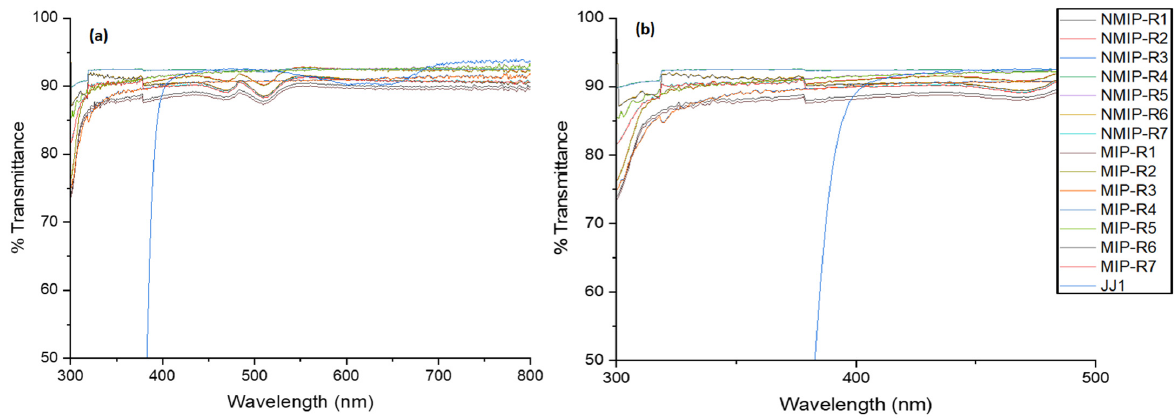
5 of 11 Figure 2. Demonstrating the FTIR spectrum for various samples compared to JJ1. X -axis here repre- sents the wavenumber in inverse cm. The y -axis in this figure is not demonstrated, due to the sam- ples being tiled above one another for easier appreciation of the dataset.